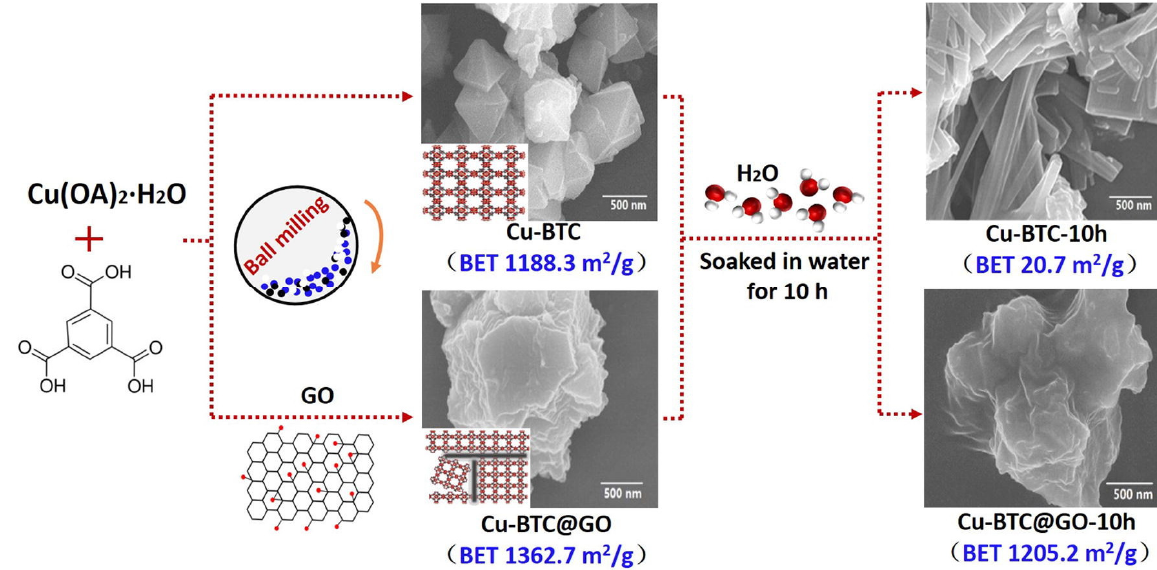
Figure 8. Synthesis pathways for Cu-BTC-10h and Cu-BTC@GO-10h [74].